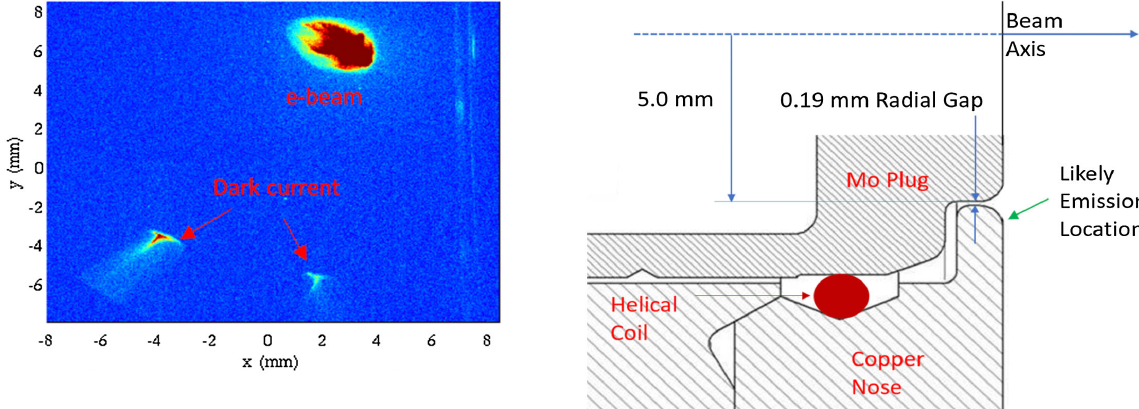
FIG. 12. Left: YAG screen image of a laser-generated electron beam and dark current. Right: geometry of the molybdenum cathode plug when inserted into the copper cathode nose.